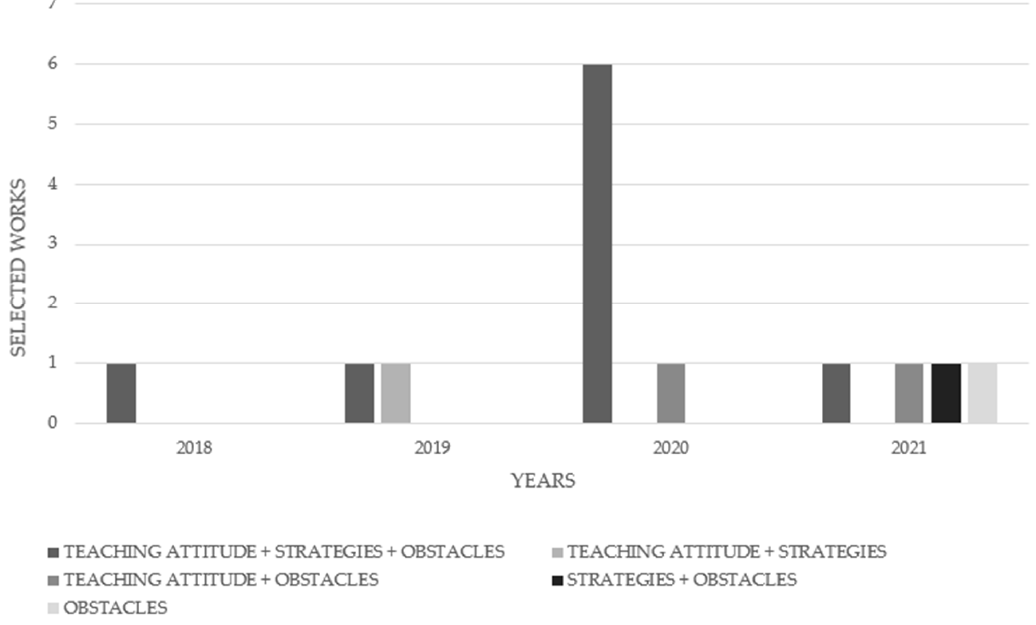
Figure 3. Number of works selected in relation to the year and theme treated.